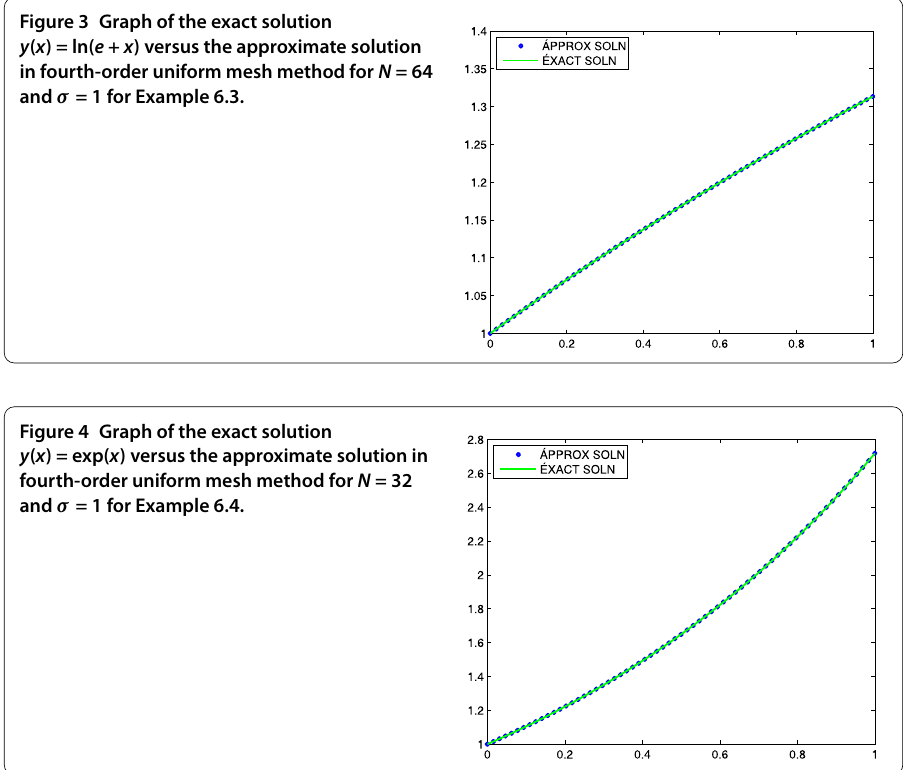
Figure 3 Graph of the exact solution y ( x ) = ln( e + x ) versus the approximate solution in fourth-order uniform mesh method for N = 64 and σ = 1 for Example 6.3.